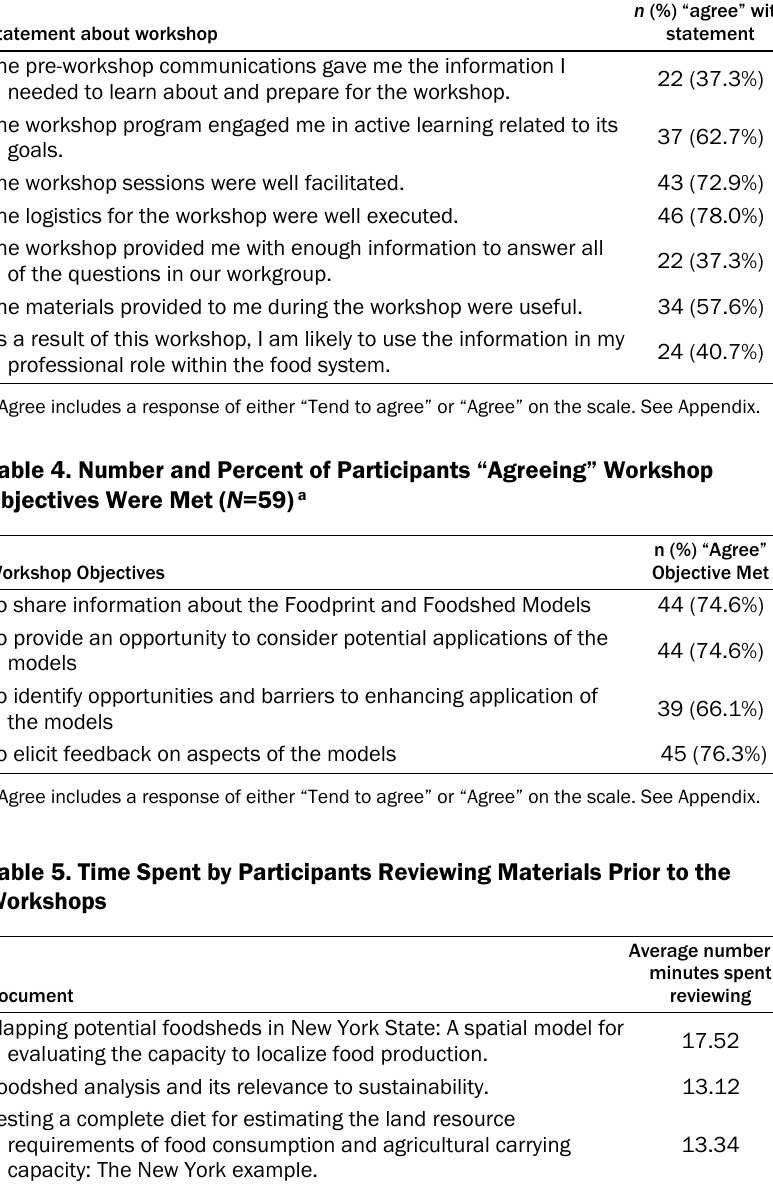
Table 3. Workshop Survey Responses Regarding the Perceived Quality of